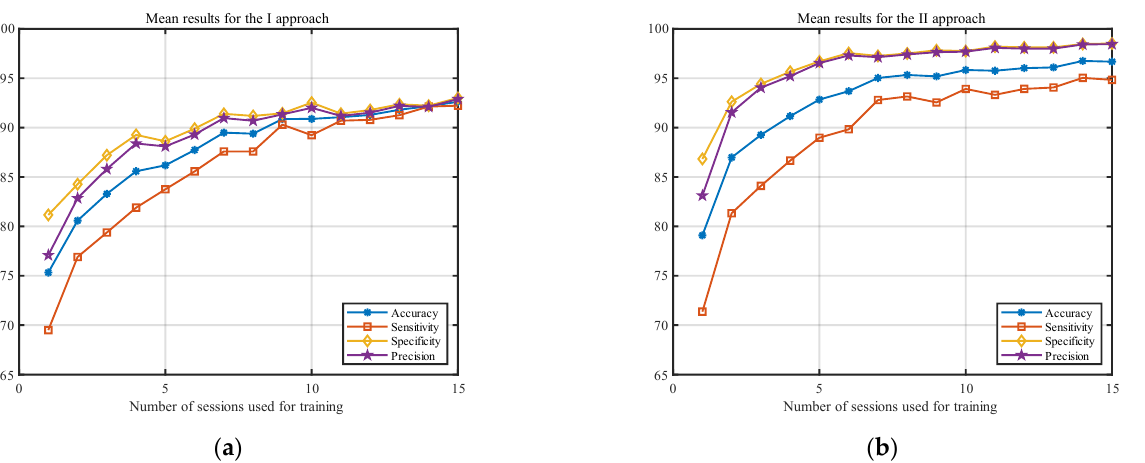
Figure 3. Results for classification measures, according to the number of sessions used for training, averaged over all individuals for the ( a ) I approach and ( b ) II approach.